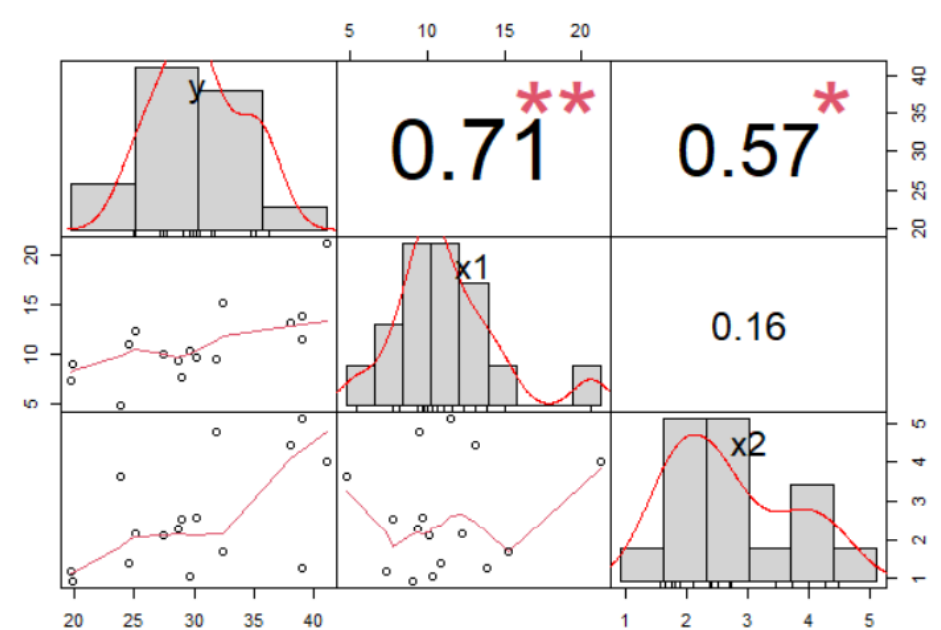
Figure 8. Pearson’s correlation coefficients and histograms for the research variables. y: ‘ power capacity in watts per person ’; x1: ‘ number of PV installations per 100 million GDP ’; x2: ‘ salary in thousand PLN ’; correlation coefficients are at the intersection of columns and rows; *, ** denote the 5% and 1% significance levels, respectively.